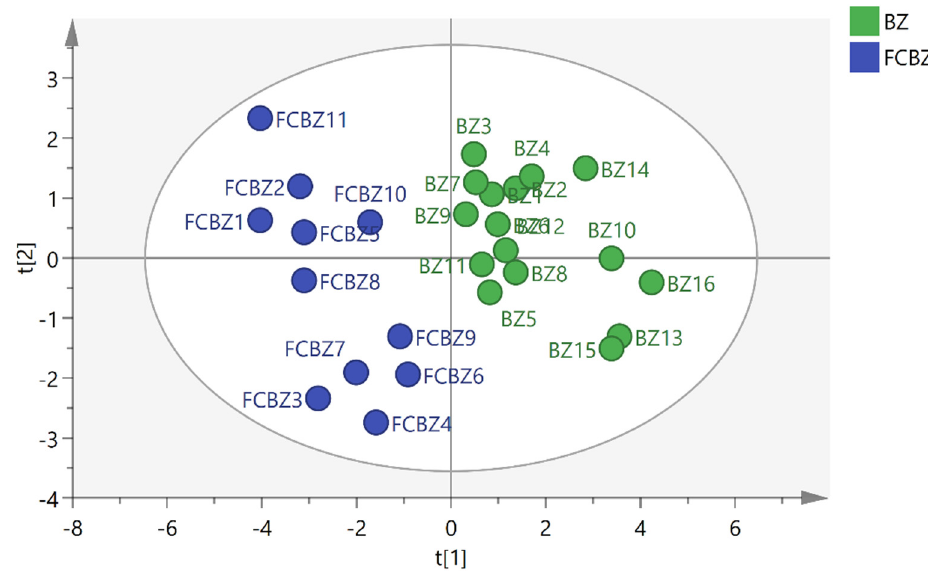
Figure 4. Principal component load diagram. ( A ) PCA score chart; ( B ) PCA-3D score chart.